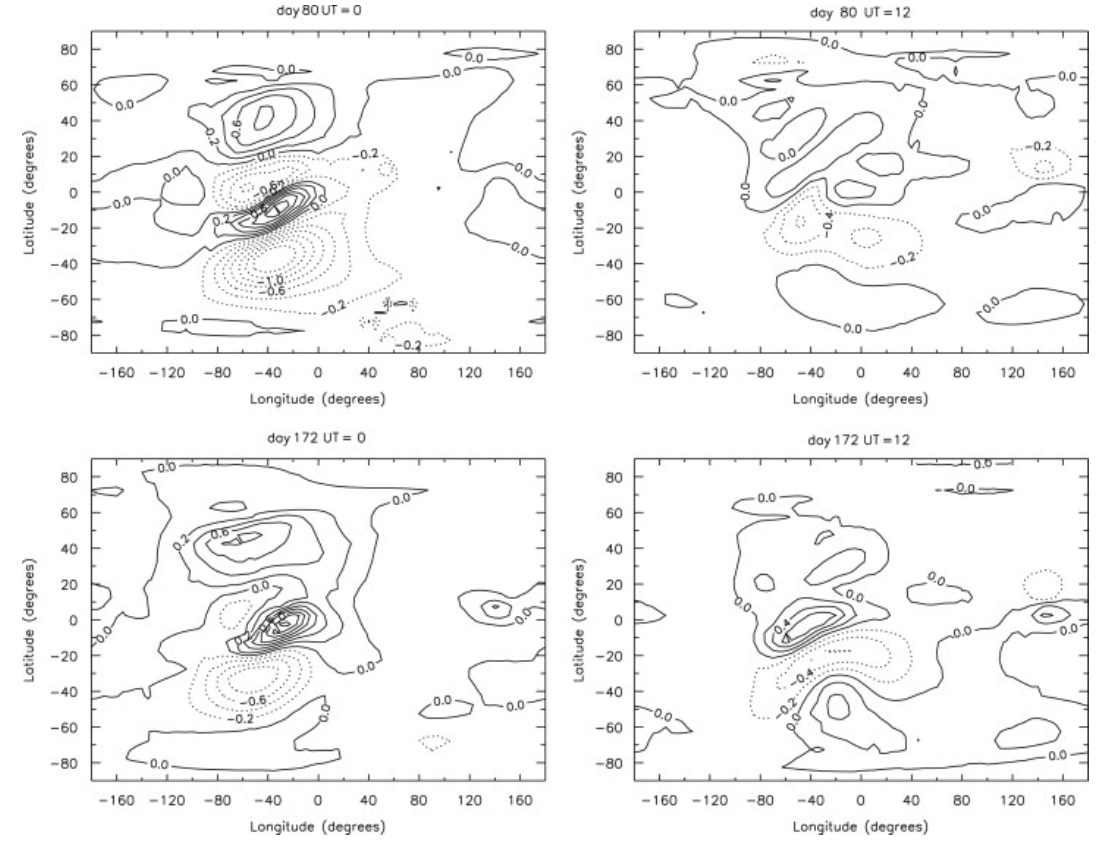
Figure 6. Global change in foF2 (MHz) at day 80 ( top ) and day 172 ( bottom ) at 0 UT ( left ) and 12 UT ( right ) between 1997 and 1957 (1997–1957). (Repdroduced from Cnossen and Richmond [38]: Figure 6).